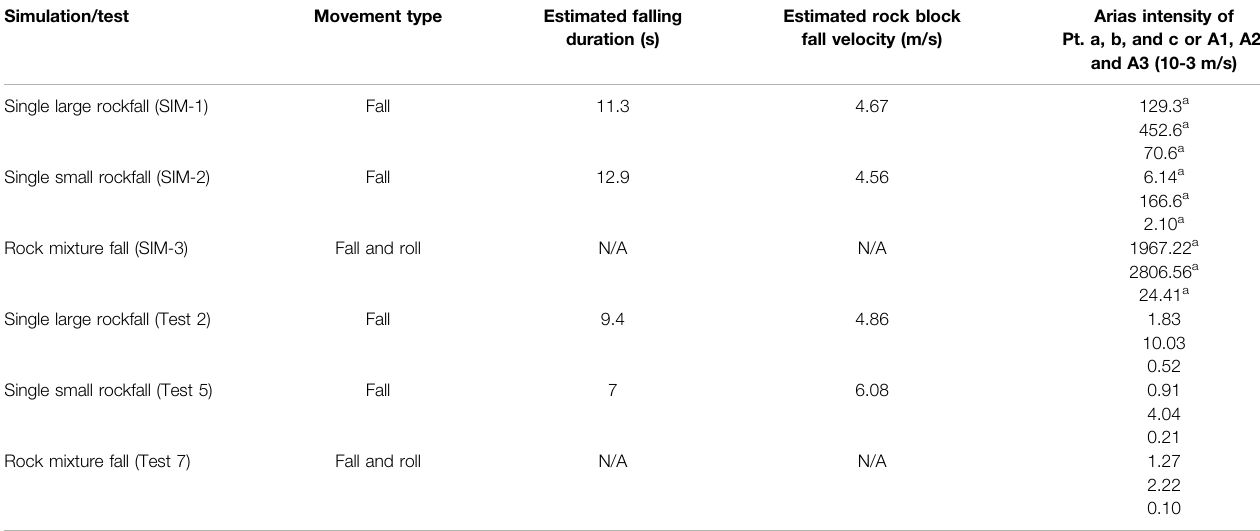
TABLE 3 | Simulation results from this study and the fi eld test results from Feng and Zhuang (2021).